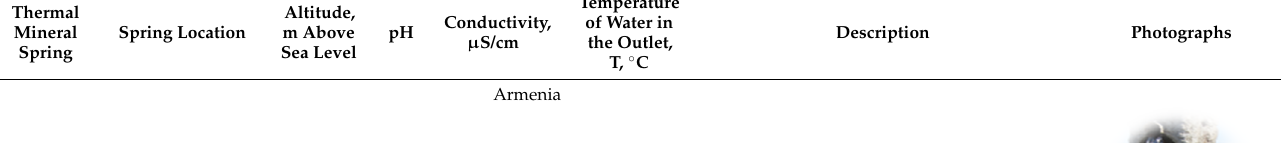
Photographs Photographs